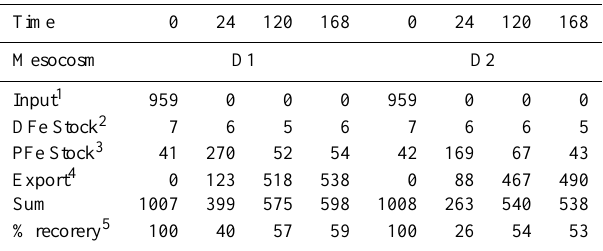
Table 2. Iron budget in the mesocosms at different time t in mg.